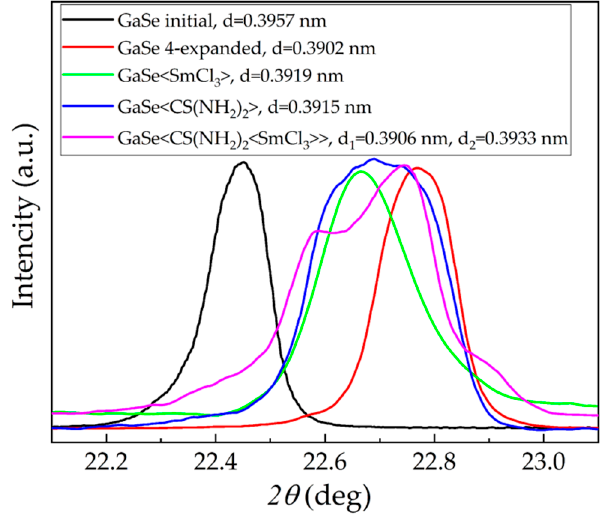
Figure 5. The XRD powder patterns of the initial GaSe and the synthesised hierarchical structures.